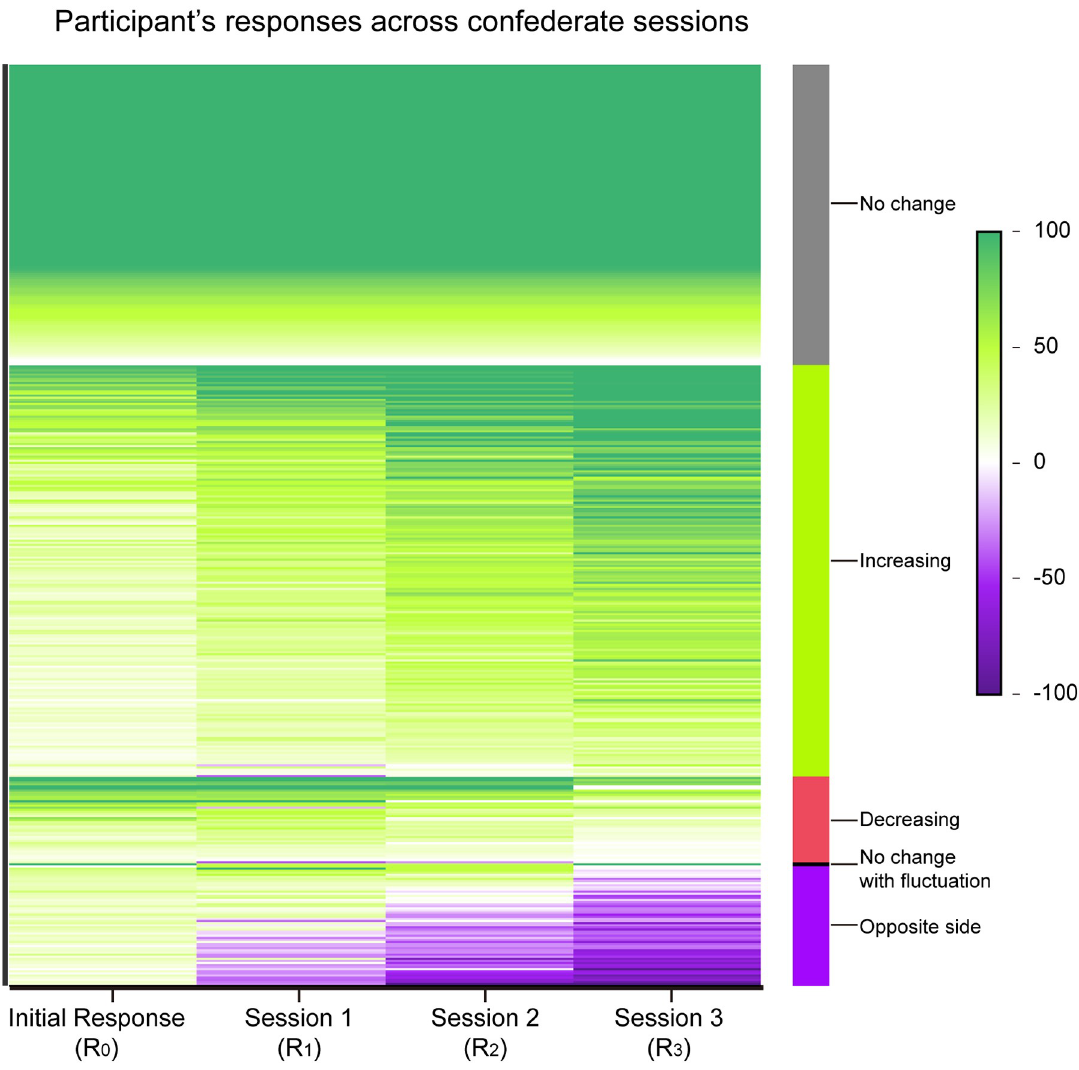
Fig 6. Participant’s responses across sessions. Heat-map plot of participants’ confidence ratings across sessions. Each line shows the responses of a participant to a particular video (n = 38 participants x 90 questions = 3420 lines). Lines are grouped and ordered by the response trend (i.e., no change, increasing, decreasing, etc.) as marked by the colour bars immediately on the right. When R 0 < 0, all participant’s responses and subsequent confederate’s confidence ratings in that particular trial were flipped as in Fig